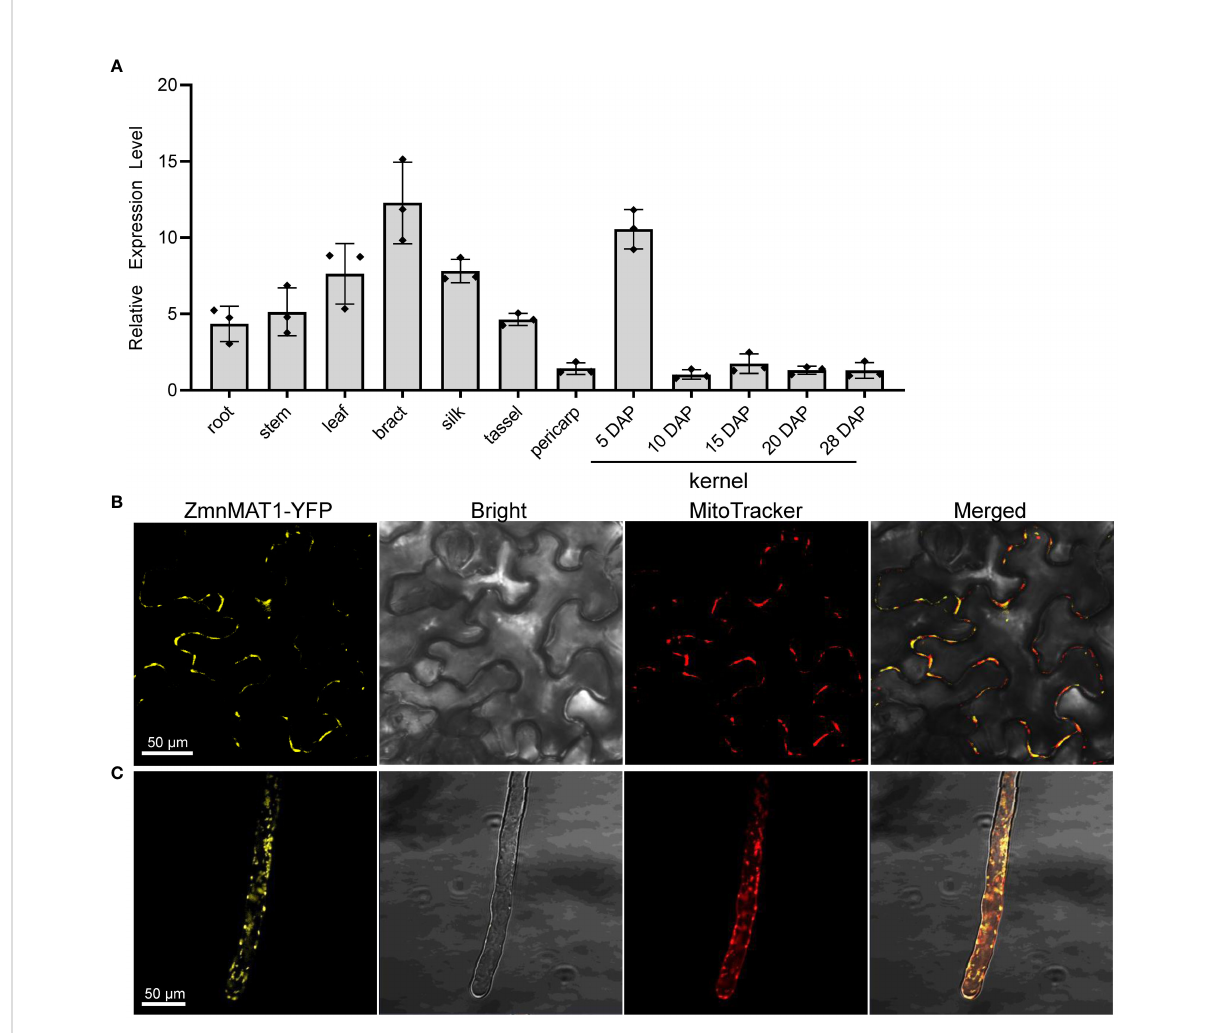
FIGURE 4 The expression pro fi le of ZmnMAT1 and subcellular localization of ZmnMAT1 protein. (A) Expression pro fi les of ZmnMAT1 in various tissues and during maize kernel development. ZmActin was used as an internal control. Data was shown as the average ± S.E. of three biological replicates. (B) Subcellular localization of 35S:ZmnMAT1-YFP fusion protein in tobacco leaf epidermis cells. MitoTracker Red was used to label mitochondria. Scale bar =50 m m. (C) Subcellular localization of 35S:ZmnMAT1-YFP fusion protein in Arabidopsis thaliana root hairs. MitoTracker Red was used to label mitochondria. Scale bar =50 m m. Fluorescence of YFP and MitoTracker were detected with excitation at 514 and 579 nm, respectively. And the master gain of YFP and MitoTracker were 731 and 500,